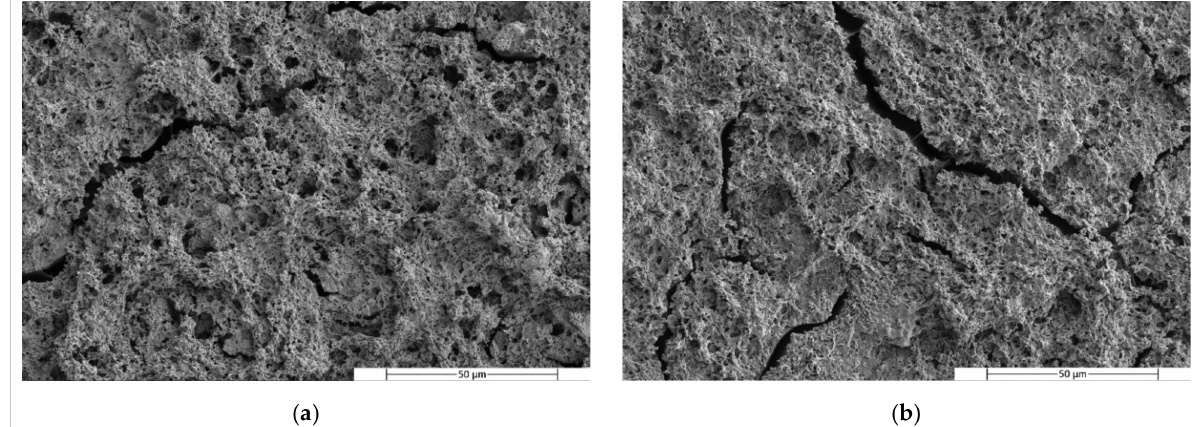
Figure 9. SEM micrographs of fractured surfaces after minor phase solving at 2500 × of ( a ) TPS80PBS20 and ( b ) TPS60PBS40